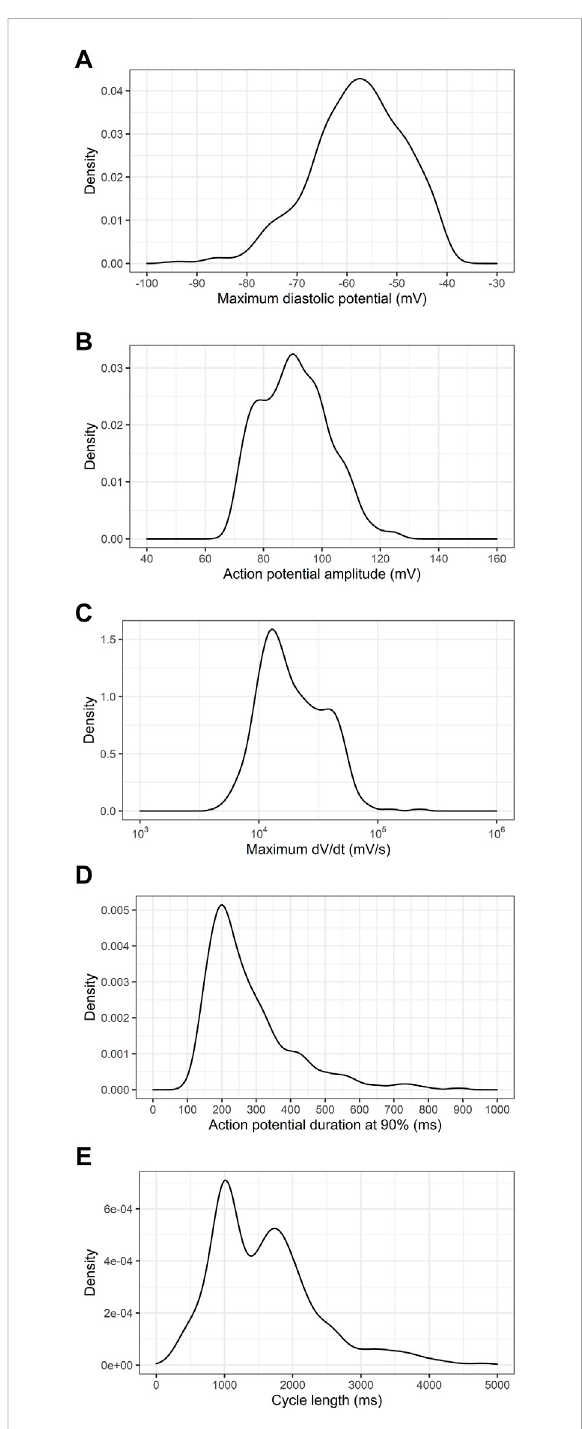
DensitydistributionofactionpotentialparametersfromPSC- derived cardiomyocytes. (A) Maximum diastolic potentials (MDP), (B) action potential amplitudes (APA), (C) maximum dV/dt (dV/dt max), (D) action potential duration at 90% repolarization (APD90) and (E) cycle length are shown for the whole dataset, comprising 780 electrophysiological